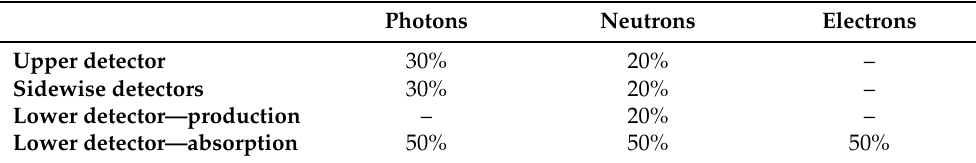
Table 6. The parameter set with the noise thresholds t min optimized for multiple lead